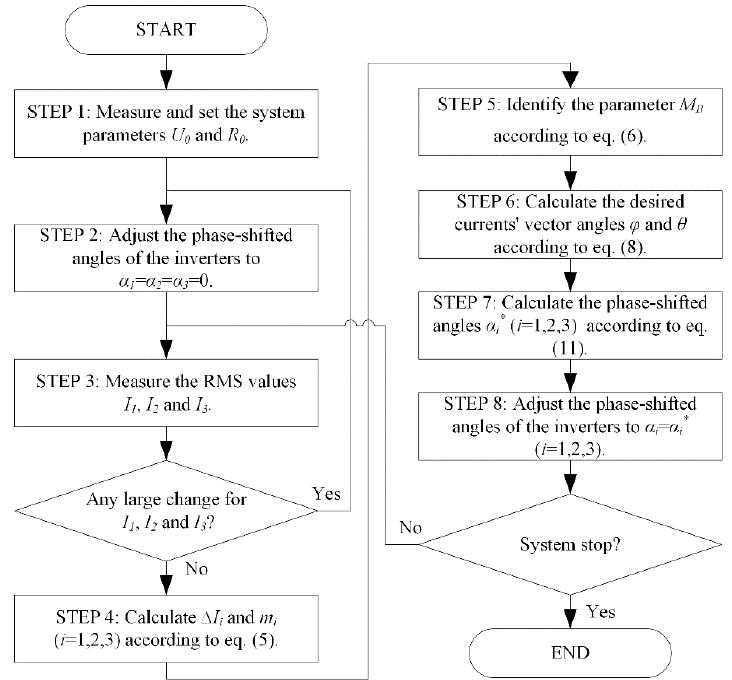
Figure 4. The control flowchart of the three-phase-shifted drive omnidirectional WPT system.